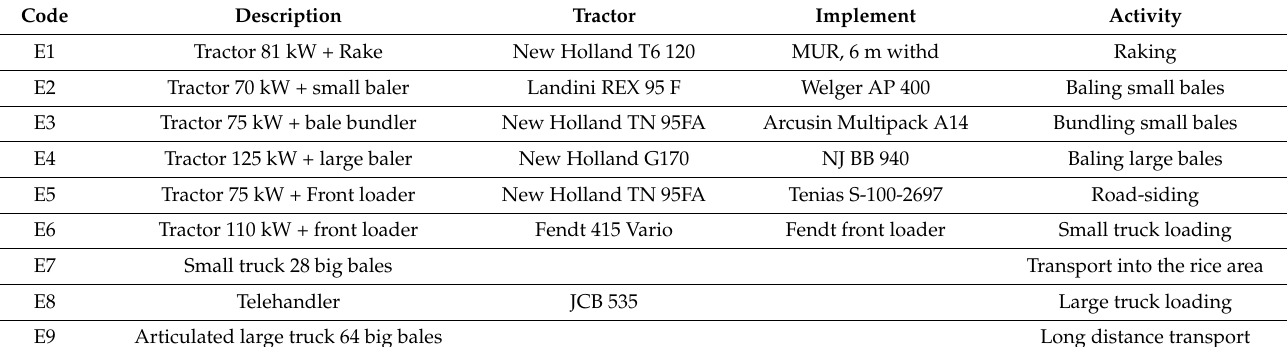
Table 1. Equipment used for packaging and transporting in the production